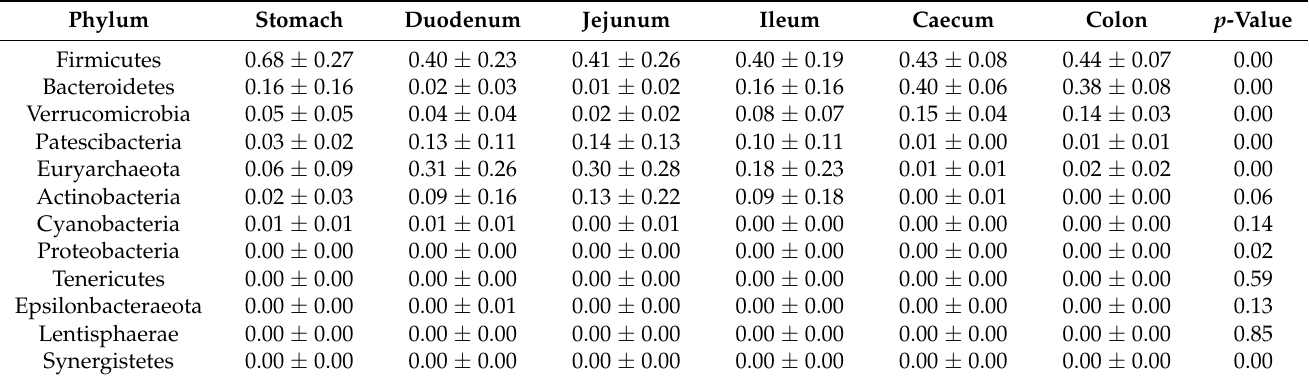
Table 1. Relative abundance of Operational Taxonomic Units (OTUs) of phyla that are significantly different between the six regions of the gastrointestinal tract analyzed in this study (stomach, duodenum, jejunum, ileum, caecum, and colon). Values are means ± standard deviations. The cut-off value for significance was p -value <